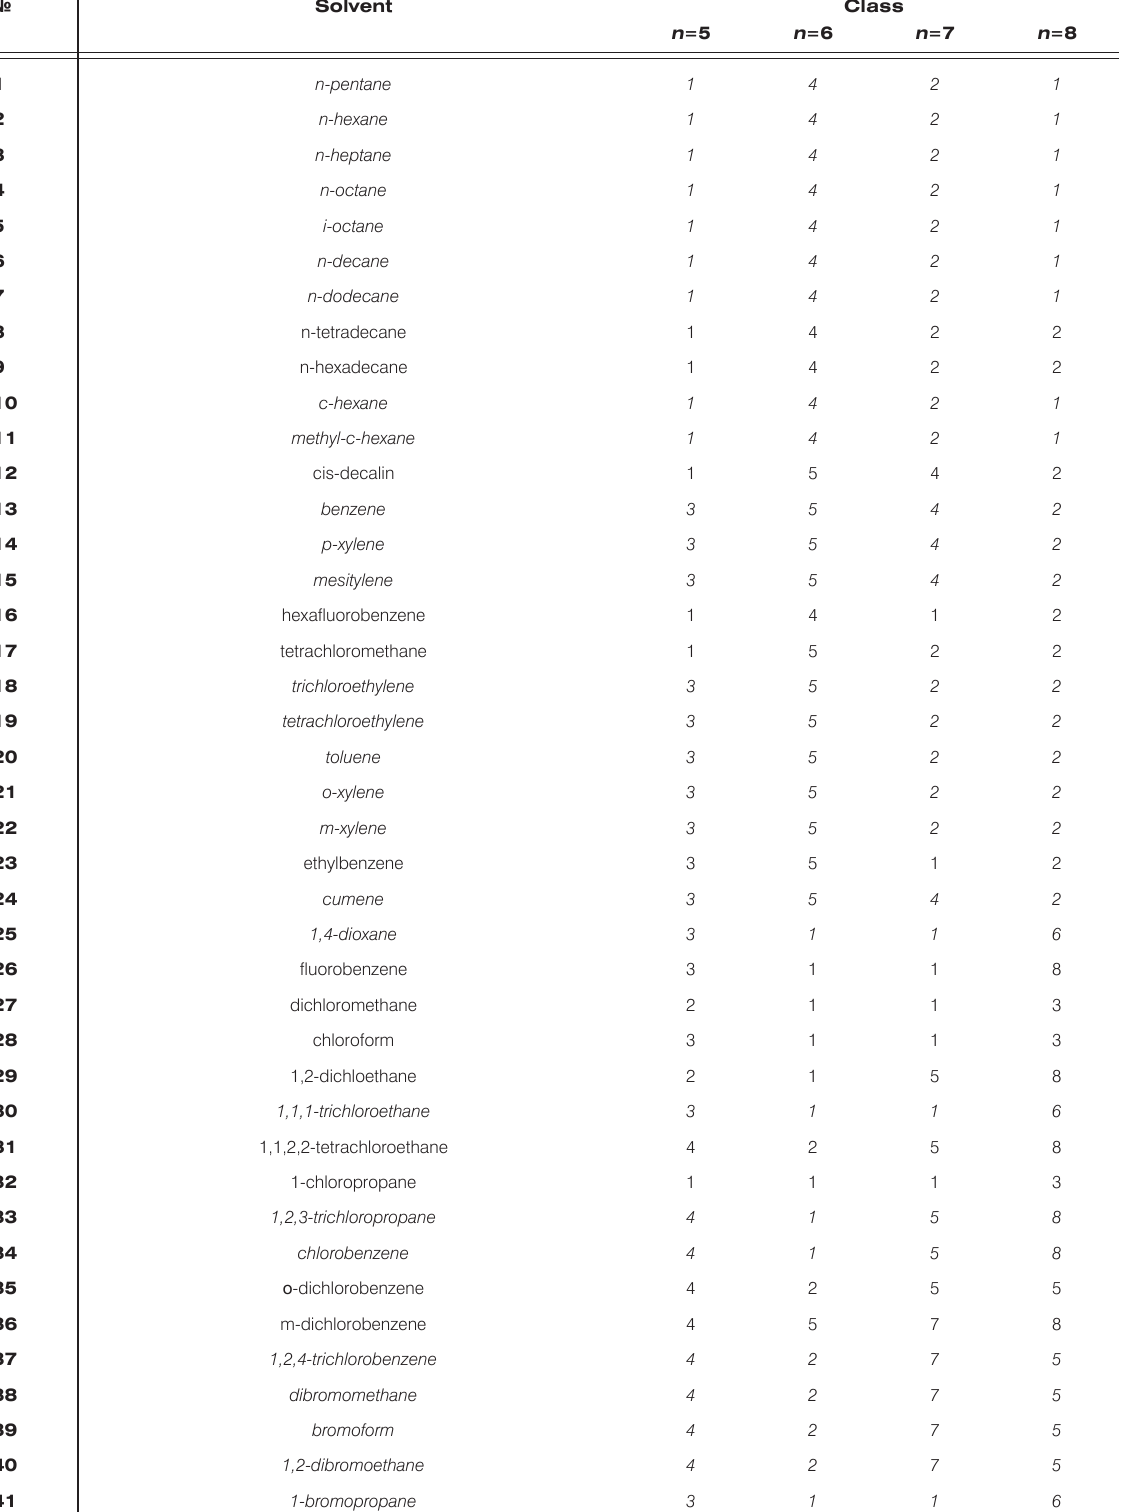
Table 1. Classification of solvents with the use of the Kohonen